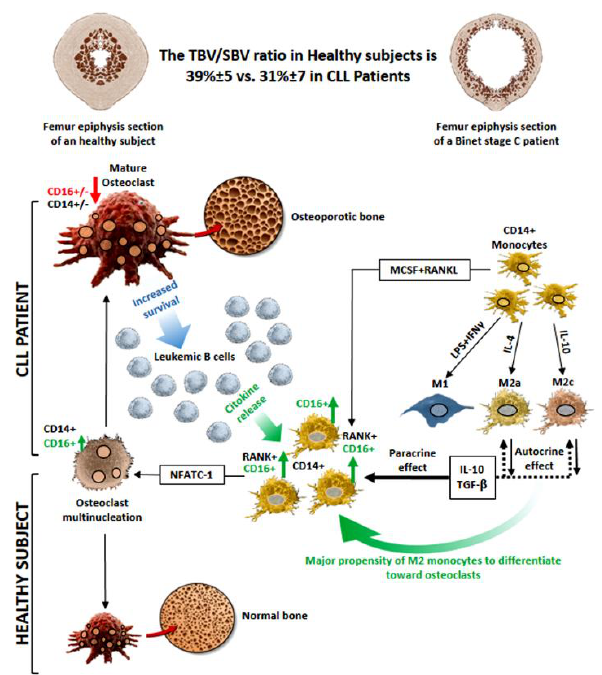
Figure 12. Osteoclast differentiation in CLL patients. Schematic representation of the multiple interactions taking place among leukemic B cells and monocytes leading to an increase in osteoclast maturation and bone resorption in CLL patients. The effects of specific cytokines released in the microenvironment leading to monocyte polarization and/or to CD16 modulation are indicated.